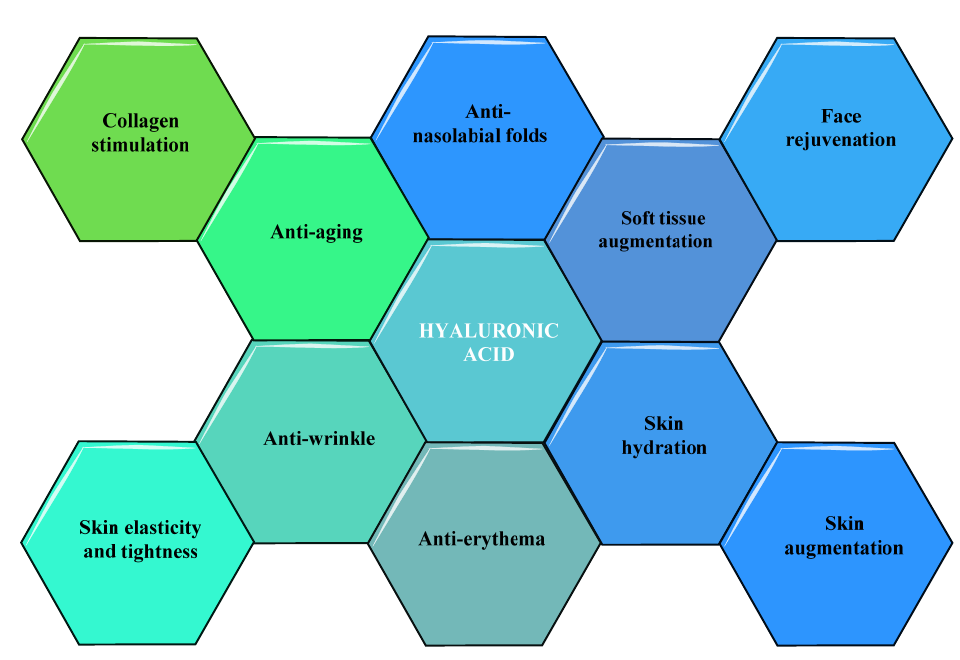
Figure 5. Cosmetic and nutricosmetic effects of